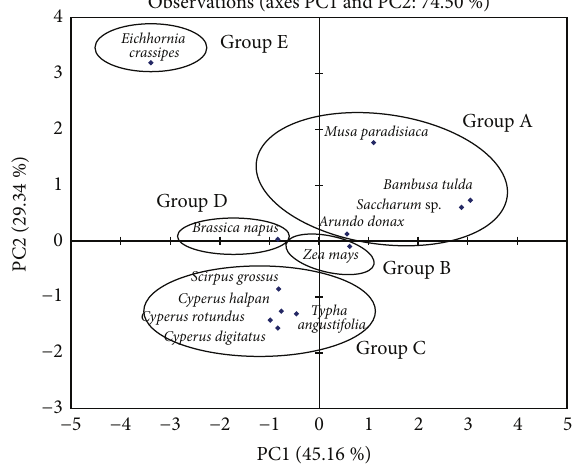
Figure 1: Principal component analysis (PC1 and PC2) of five aquatic plant species compared with other nonwood plant species based on their fiber dimensions and derived